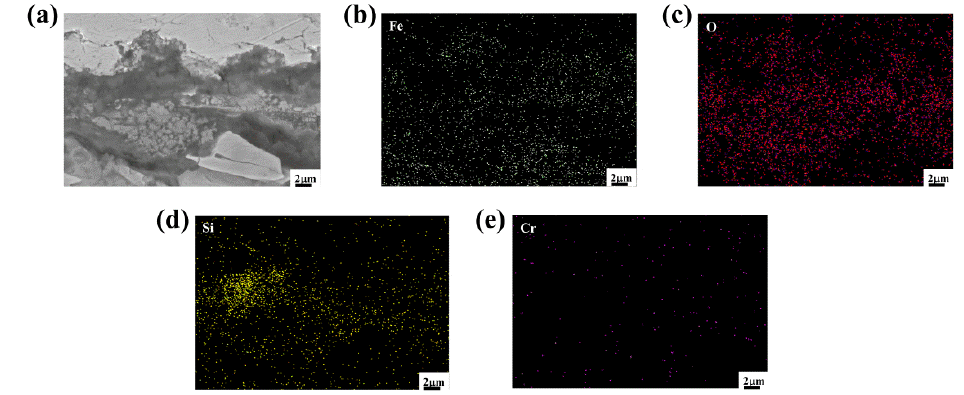
Figure 13. The EDS mapping of a cross-section of the Fe 2 B ⊥ A4 sample oxidized for 60 h at 1073 K: ( a ) micrograph of surface scanning, ( b ) element distribution of Fe, ( c ) element distribution of O, ( d ) element distribution of Si, ( e ) element distribution of Cr.